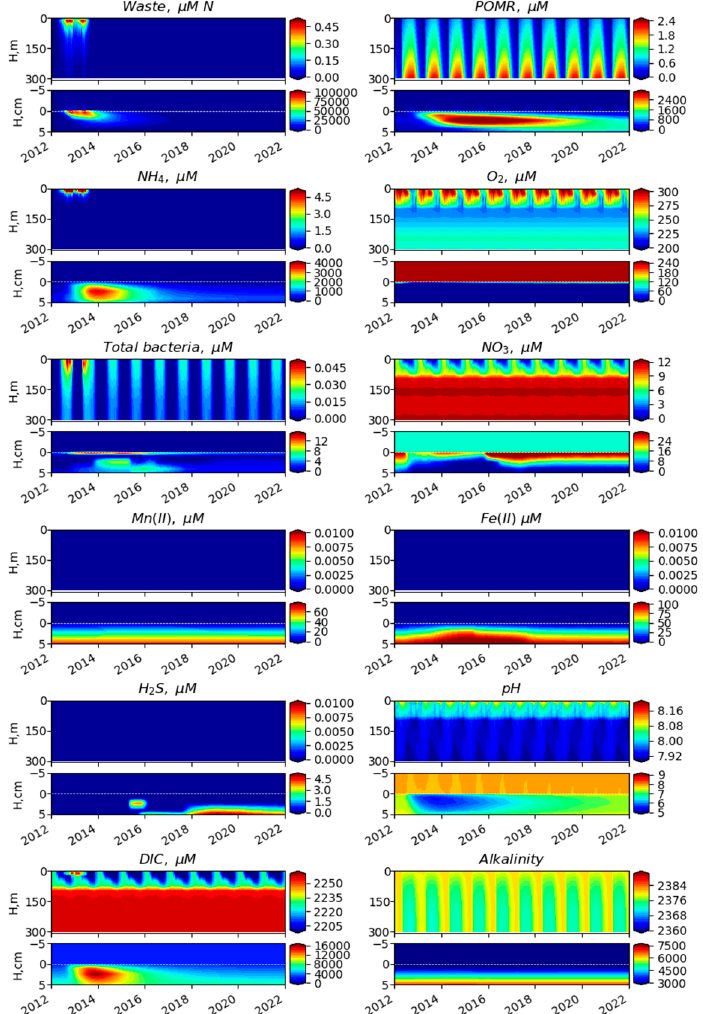
Figure 12. Temporal variability of the model parameters during the 10 years below the fish farm operated in first two years.